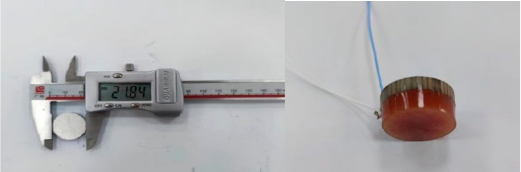
Figure 17. Narrowband ( Left ) And Broadband ( Right ) Receiving Arrays.